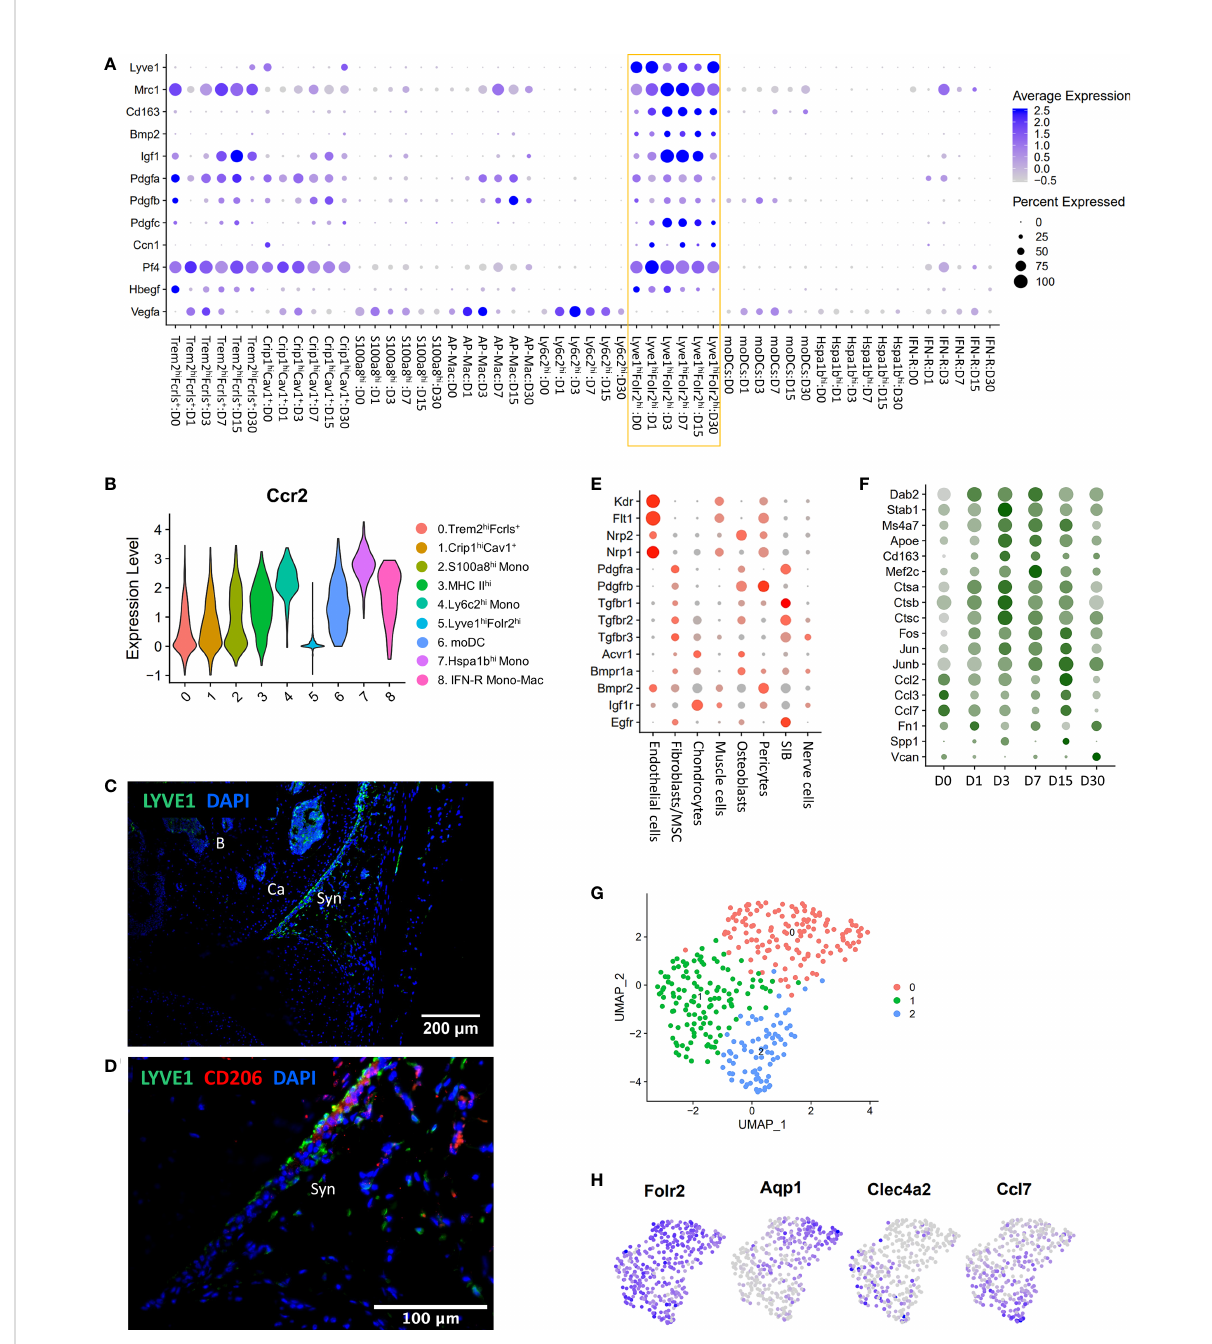
FIGURE 4 Characterization of Lyve1 hi Folr2 hi macrophages. (A) Dot plot showing enrichment of growth factors in Lyve1 hi Folr2 hi macrophages (yellow box). Dot size represents the fraction of cells expressing a speci fi c gene while the intensity of color indicates the average expression level for each gene. (B) Violin plot showing the expression of Ccr2 in various monocyte/macrophage subtypes. Lyve1 + macrophages showed signi fi cantly lower Ccr2 expression. (C) IHC analysis of Lyve1+ macrophages at D0 (10× magni fi cation; scale bar = 200 m m). Lyve1 + macrophages were primarily present at the synovial lining at D0. B: bone; Ca: cartilage; Syn: synovium. (D) Co-expression of Lyve1 and CD206 at the synovial lining at D0 (40× magni fi cation; scale bar = 100 m m). (E) Growth factor receptor expression in connective tissue-forming cells from the joint. Dot size represents the fraction of cells expressing each gene (grey: low expression; red: high expression). (F) Genes upregulated in Lyve1 hi Folr2 hi macrophages after injury. Dot size represents the fraction of cells expressing each gene (grey: low expression; green: high expression). (G) UMAP plot showing 3 subtypes of Lyve1 hi Folr2 hi macrophages. (H) Feature plots showing the expression of Folr2 and markers of various subtypes of Lyve1 hi Folr2 hi